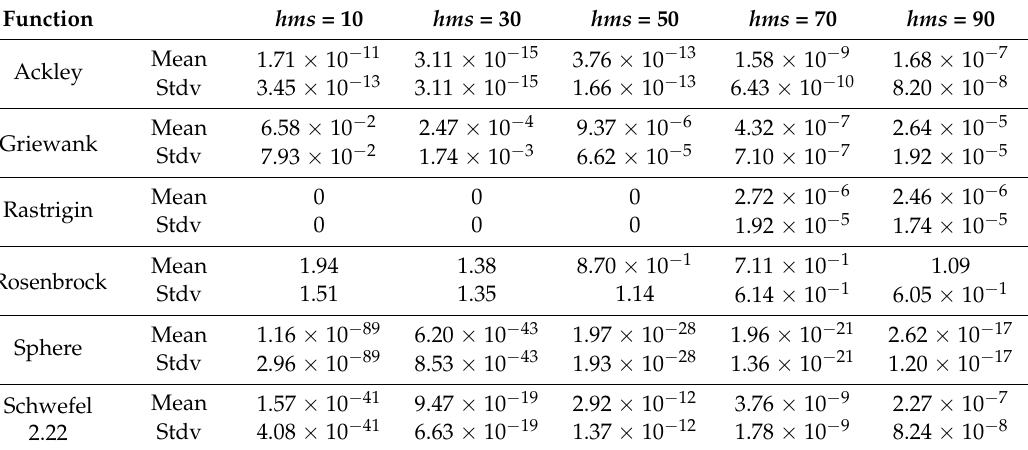
Table 6. The effect of hms on means and standard